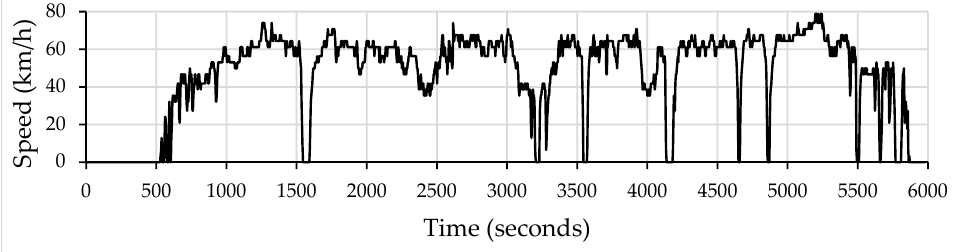
Figure 6. 80 km monitoring cycle—speed—from Midlothian to Galashiels.